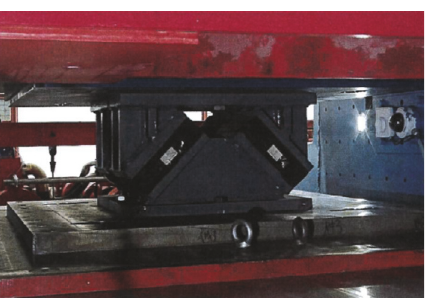
Figure 6: Test specimen of novel antivibration bearing.